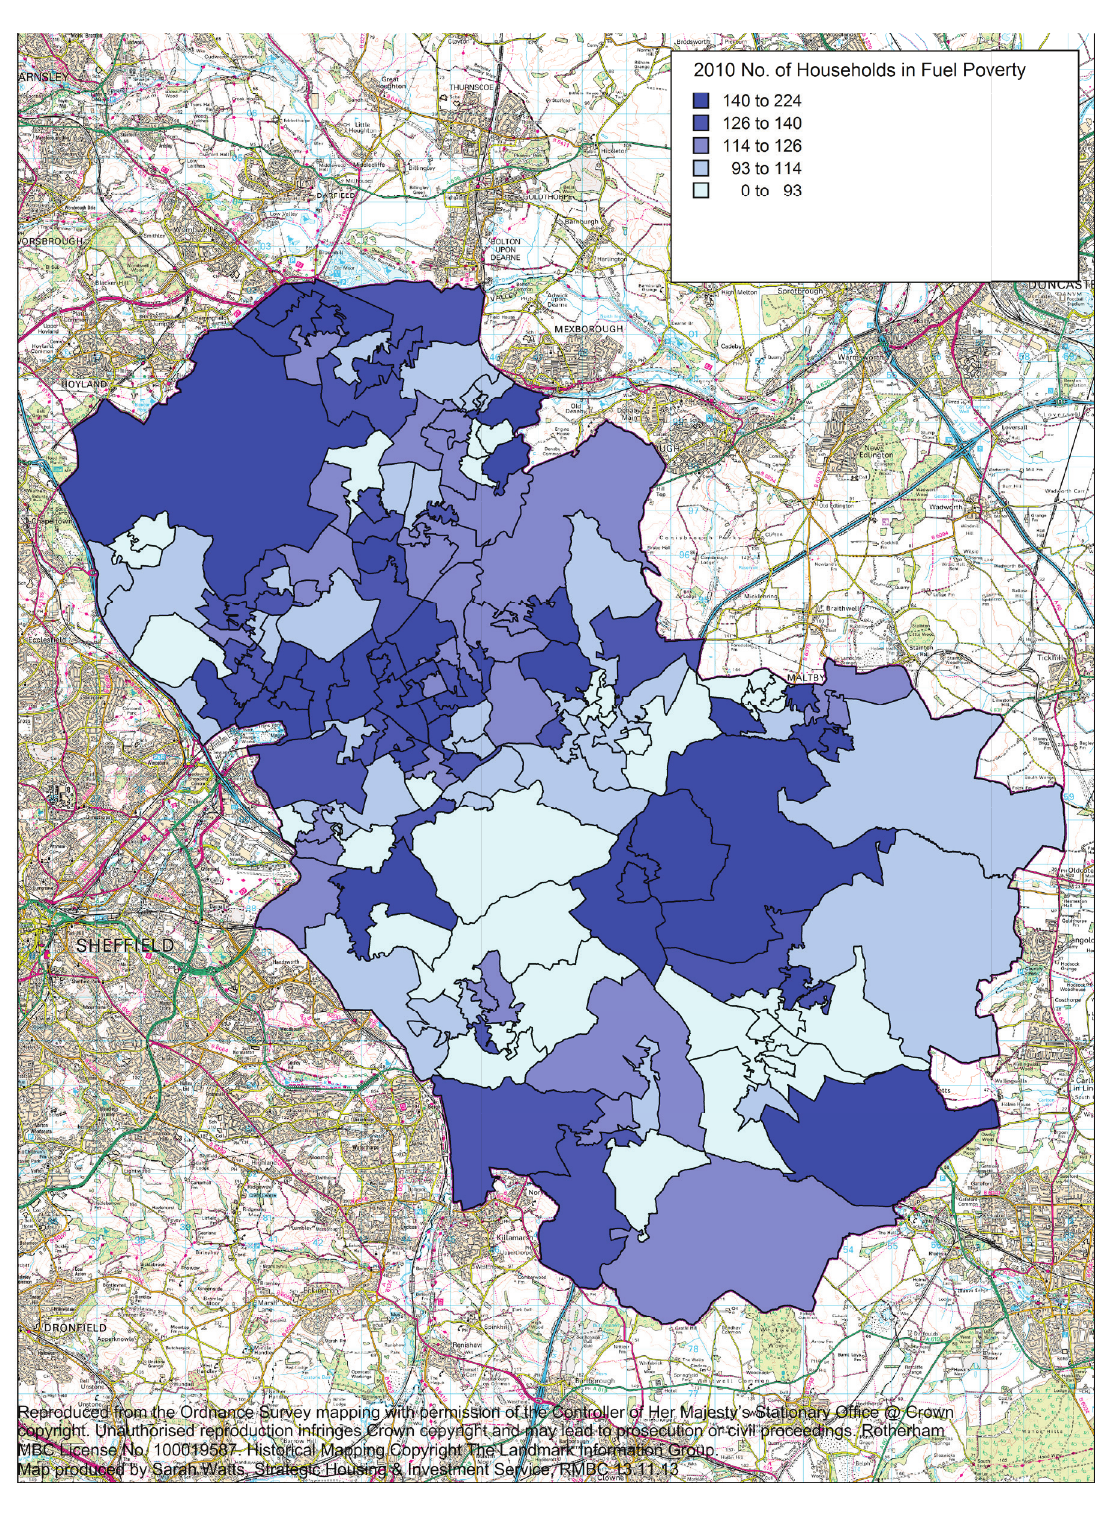
Figure 2 Map of fuel poor households in Rotherham using the 10 per cent definition of fuel